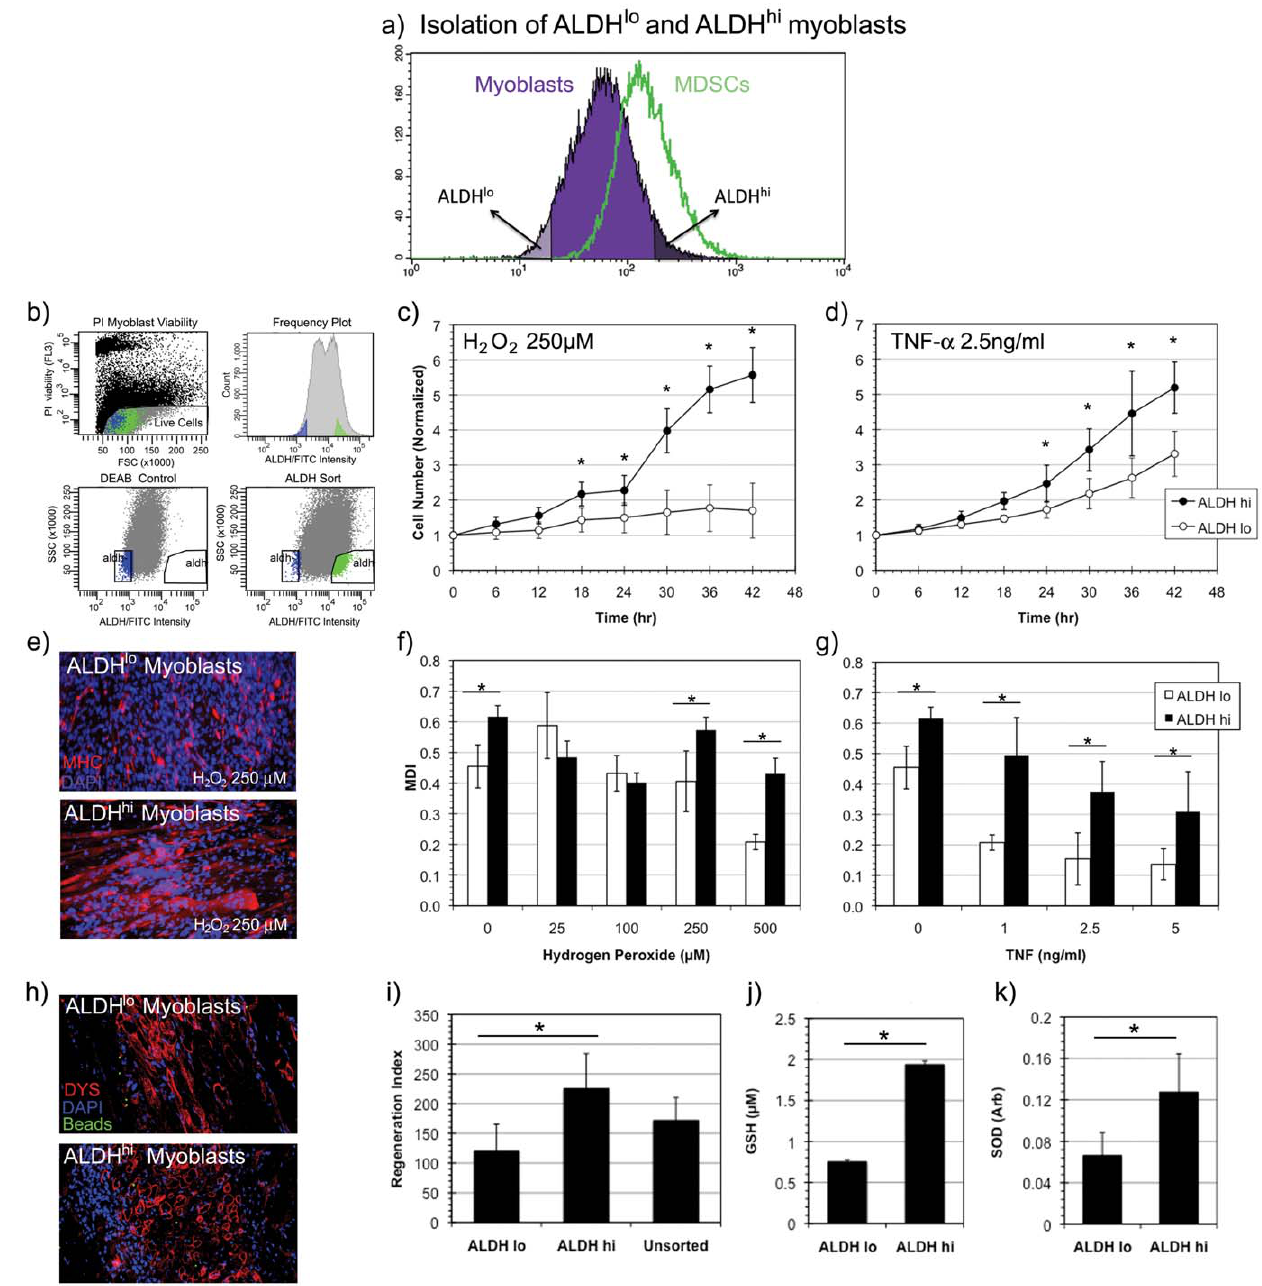
Figure 2. Isolation and stress resistance capacity of ALDH hi myoblasts. (a, b) ALDH hi murine myoblasts were isolated via fluorescence activated cell sorting (FACS) from a heterogeneous population of skeletal muscle derived cells using DEAB, a potent inhibitor of ALDH, as a gating control. (c, d) A significantly increased rate of proliferation of ALDH hi myoblasts compared to ALDH lo myoblasts was observed in conditions of oxidative stress (H 2 O 2 , 250 m M) (* indicates p , 0.05) and inflammatory stress conditions (TNF- a , 2.5 ng/ml) (n=9). (e) ALDH lo and ALDH hi myoblasts underwent myogenic differentiation by fusing into MHC + myotubes (red) under oxidative stress conditions (H 2 O 2 , 250 m M). Nuclei were stained with DAPI (blue). (f) Significantly increased myogenic differentiation indices (MDI) were observed in ALDH hi cells at several concentrations of oxidative stress (0, 250 and 500 m M) when compared to ALDH lo (n=3). (g) Similarly increased MDIs of ALDH hi cells were observed under all inflammatory stress conditions when compared to ALDH lo myoblasts. (h) An increased number and density of dystrophin positive myofibers (stained in red) were observed in mdx mice injected intramuscularly with ALDH hi cells compared to those injected with ALDH lo myoblasts. Nuclei are DAPI (blue) stained. Green FluoSphere beads are observed to localize at the area of initial injection. (i) A significantly increased regeneration index was observed in ALDH hi transplanted mice compared to those injected with ALDH lo and unsorted cells. (n=3) (j, k) Measurements of intracellular antioxidants glutathione (GSH) and superoxide dismutase (SOD) levels demonstrated statistically significant elevation of both antioxidants in ALDH hi myoblasts compared to ALDH lo myoblasts (n=3).